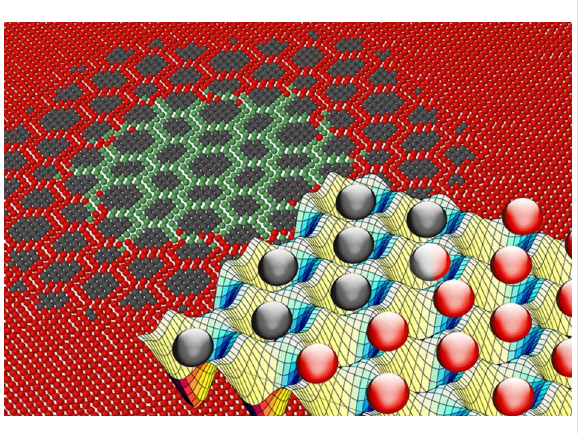
Figure 4: Front perspective: a snapshot of a MD-simulated frictional interface between a colloidal monolayer and an optical periodic sub- strate potential representing the surface corrugation. Background: the overlayer/substrate lattice mismatch (an experimentally tunable param- eter) generates a network of localized solitonic structures (highlighted by the particle colors), the mobility of which rules the tribological response of the